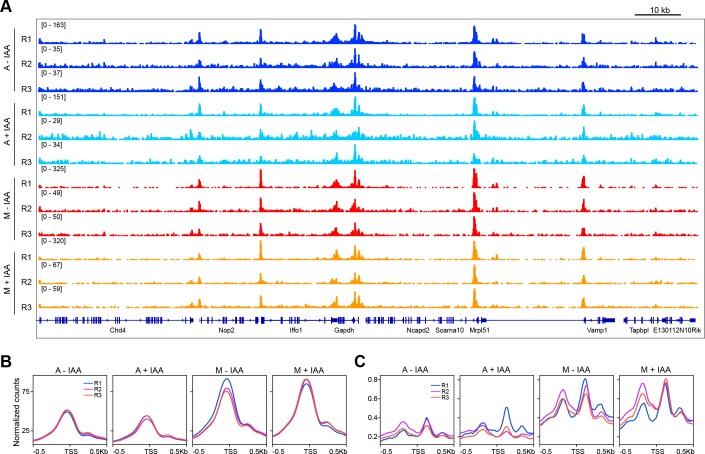
ATAC-seq replicates.(A) Genome browser snapshot of a genomic region in Chr 6, showing each replicate for each sample. A, asynchronous. M, mitosis. R1, replicate 1. R2, replicate 2. R3, replicate 3. (B–C) Average plots for reads under 100 bp (B) and for 180–250 bp reads (C) in a 1 kb region centered at the TSS for each replicate of each sample.